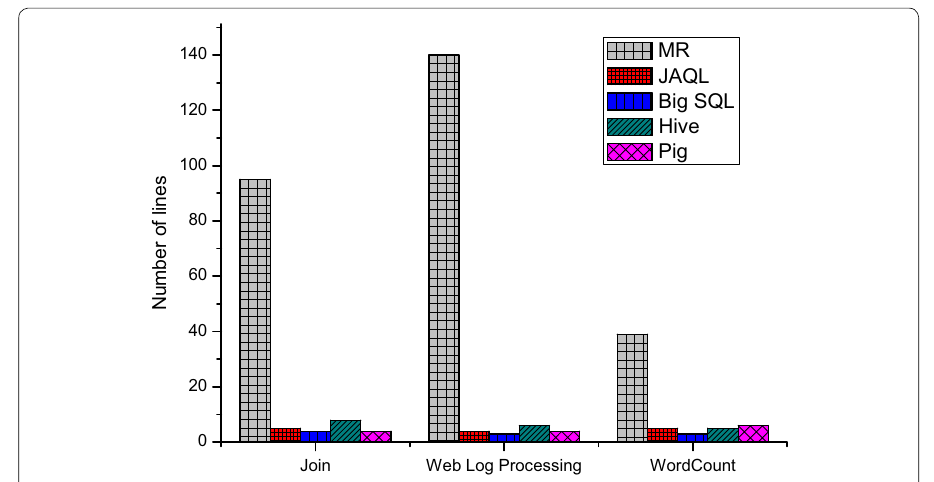
Fig. 7 Source lines of code comparison of the four MapReduce‑based